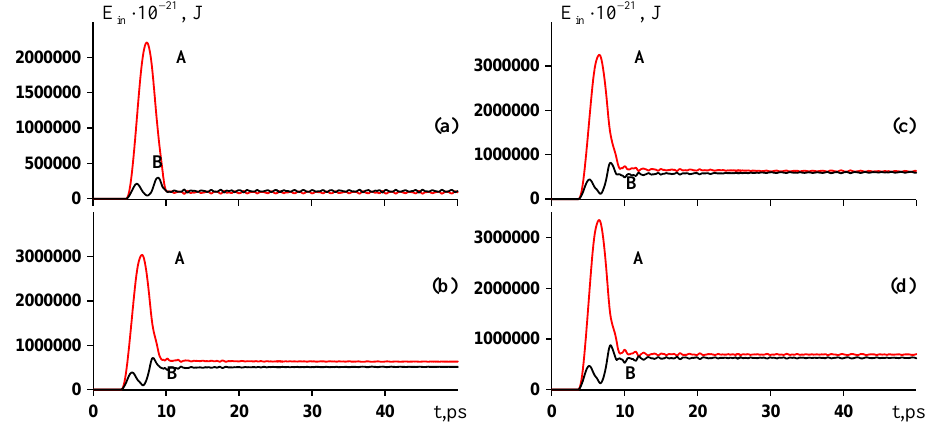
Fig. 2. The internal potential energy (A) and the kinetic energy of the chaotic motion of atoms (B) versus time. Initial impact velocity: (a) – 1100 m/s, (b) – 1300 m/s, (c) – 1350 m/s, (d) – 1370 m/s.